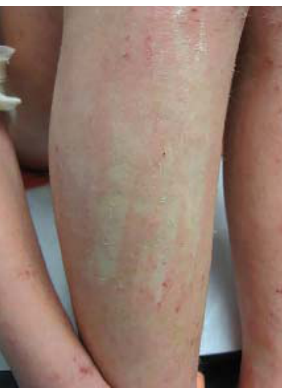
Figure 5. Dermatographism.